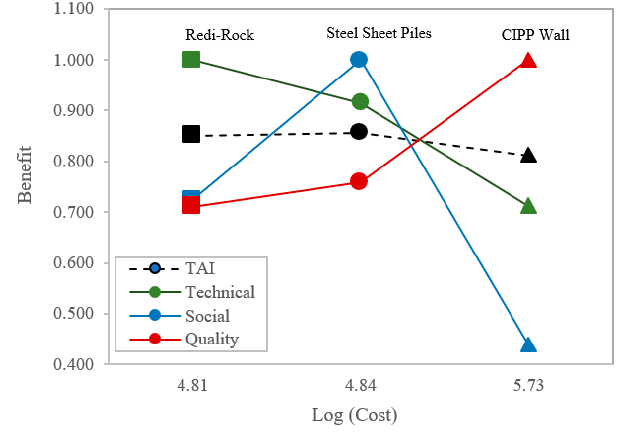
Figure 7. Incremental analysis for retaining wall alternatives.